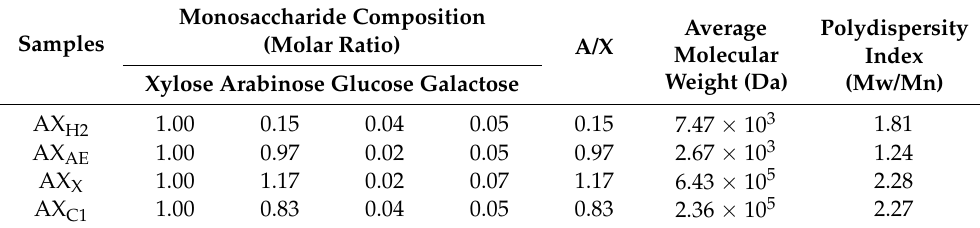
Table 1. Molecular weight and monosaccharide composition of